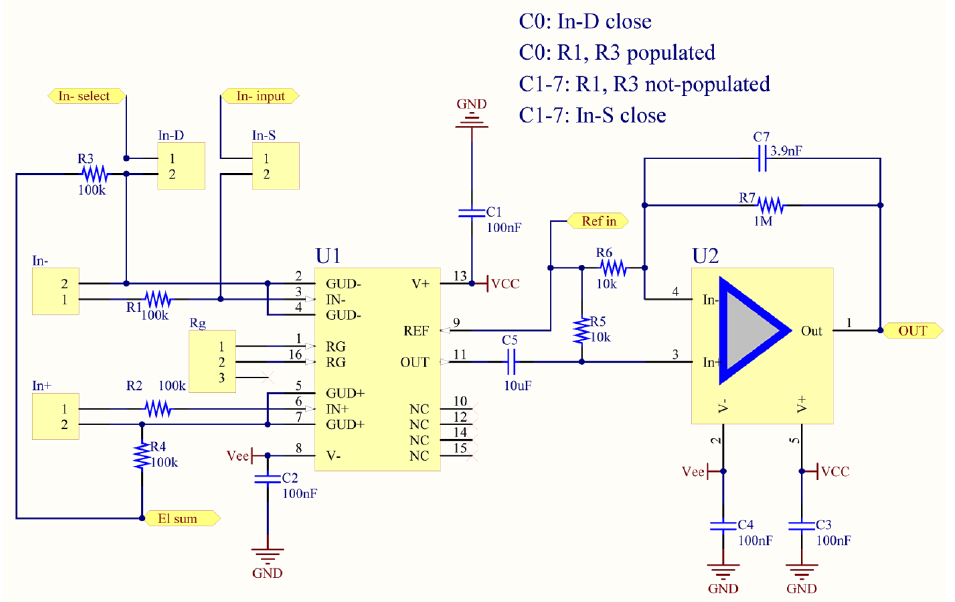
Figure 1. Analogue Front-end schematic (screen capture from Altium Designer).